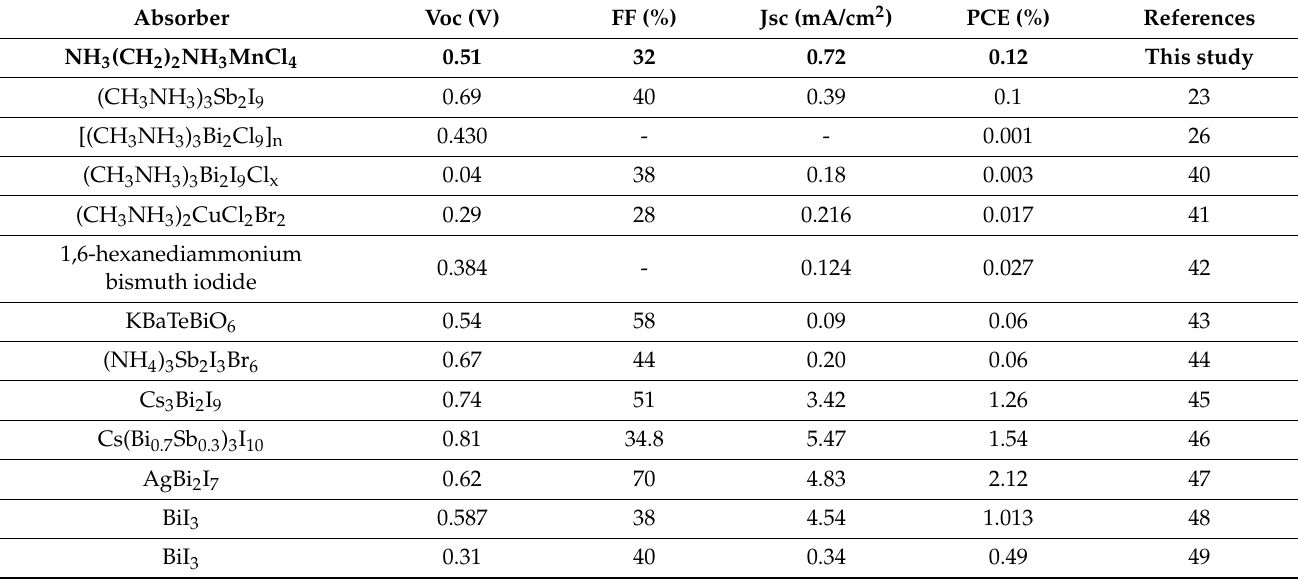
Table 2. Comparison of Voc, Jsc, FF, and PCE of the fabricated NH 3 (CH 2 ) 2 NH 3 MnCl 4 -based PSCs with recently published experimental works